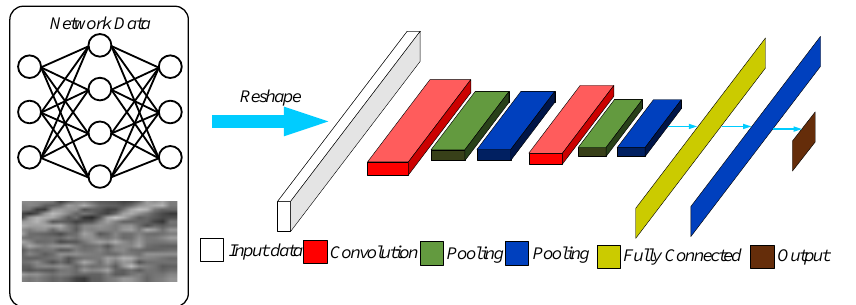
Figure 1. Typical convolutional neural network structure.